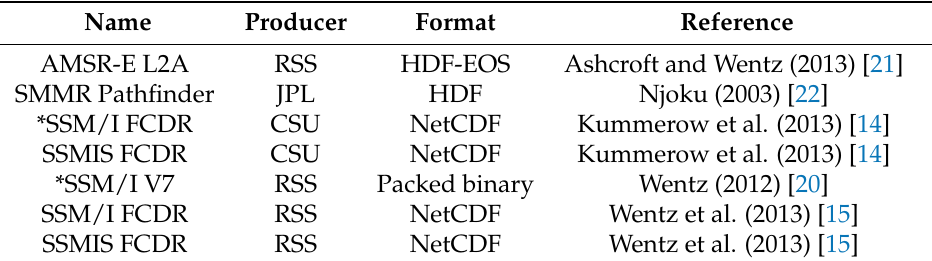
Table 1. CETB system input data sources. The original system only handled inputs marked